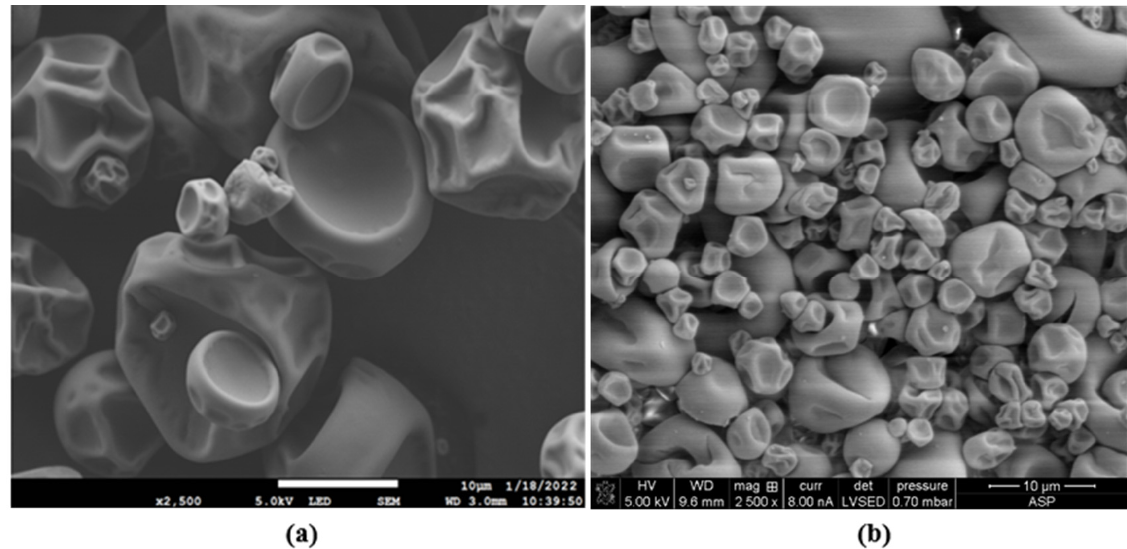
Figure 7. Images of microcapsules of red banana peel extract microencapsulated by spray drying with: ( a ) GA and ( b ) SPI. All at 5 kV and 2500× magnification.